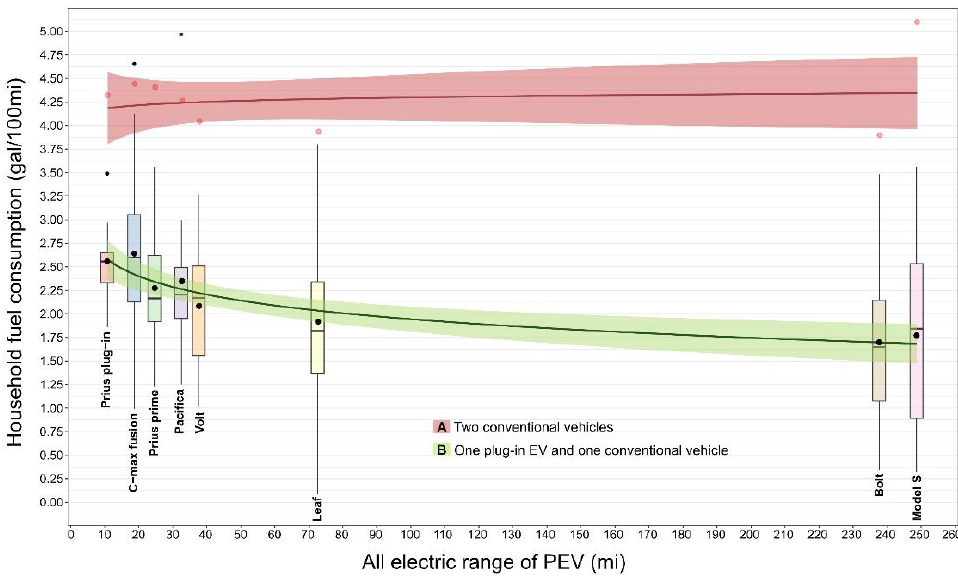
Figure 3. Household fuel consumption vs. range of PEV in two-car households.